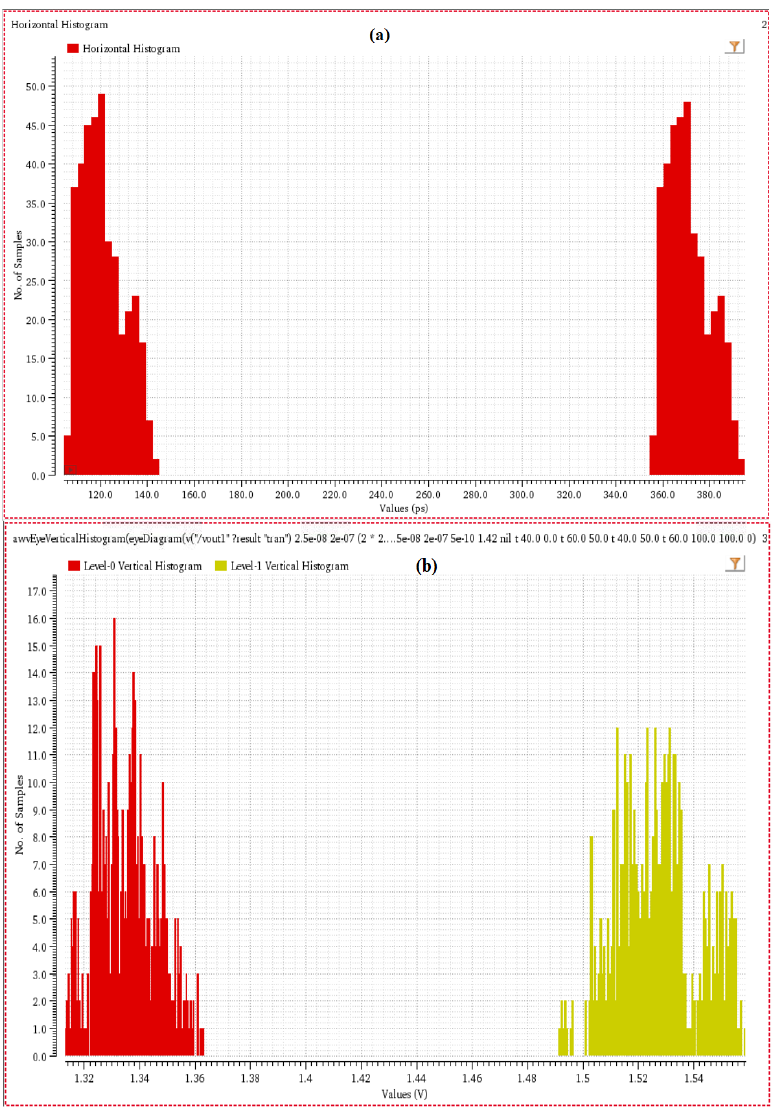
Figure 15. ( a ) Horizontal Histogram and ( b ) Vertical Histogram of eye diagrams for the 0 and 1 levels. Simulated BER bathtub curves for NRZ input data rates of 6 Gb/s are presented in Figure 16. The BER variations for different positions of the sampling point for both time delay and the voltage–power relationship are presented in Figure 16. In this case, BER(t) was 0.16 × 10 − 12 . Table 1 summarizes the key performance metrics of the proposed CTLE and other recently published CTLEs. The proposed CTLE achieved a peaking frequency with constant current for tuning its equalization competence.